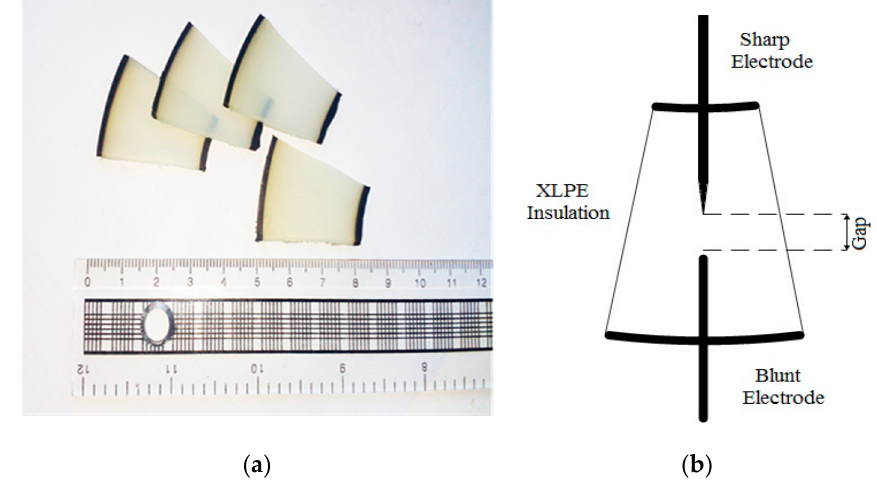
Figure 2. Test sample preparation: ( a ) samples; and ( b ) final test sample with electrodes.